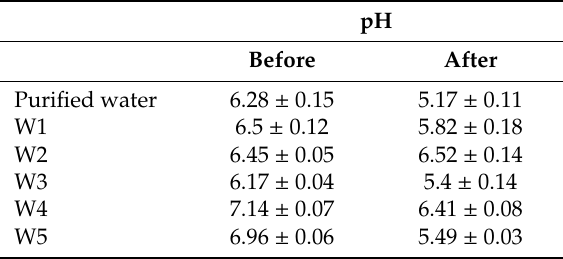
Table 2. pH values before and after the heating–cooling cycle (HCC).